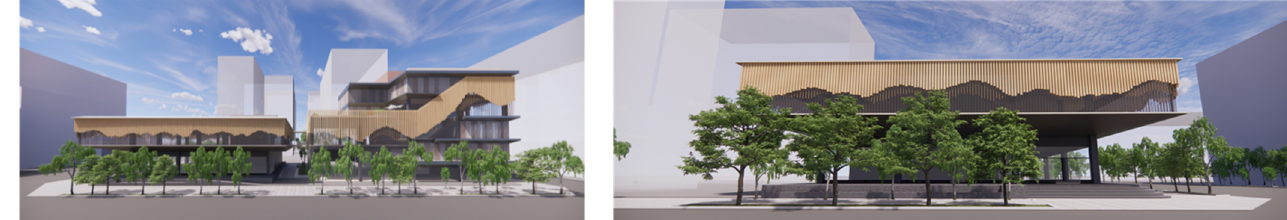
Figure 7. The possibility of façade design (Participant C).